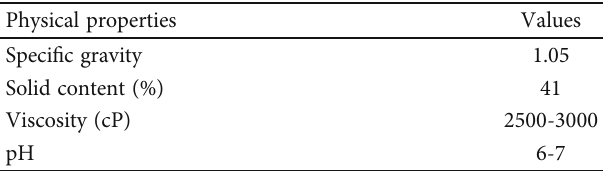
Table 2: Physical properties of liquid